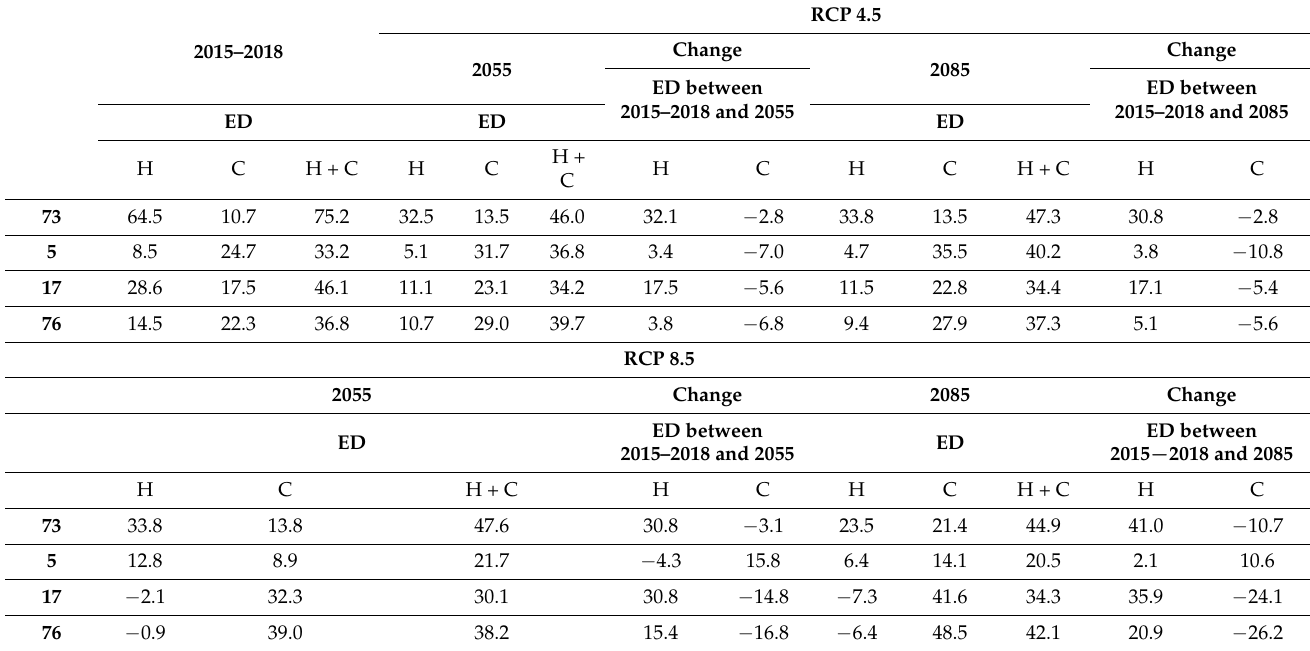
Table 5. Dynamics of changes in energy demand between significant